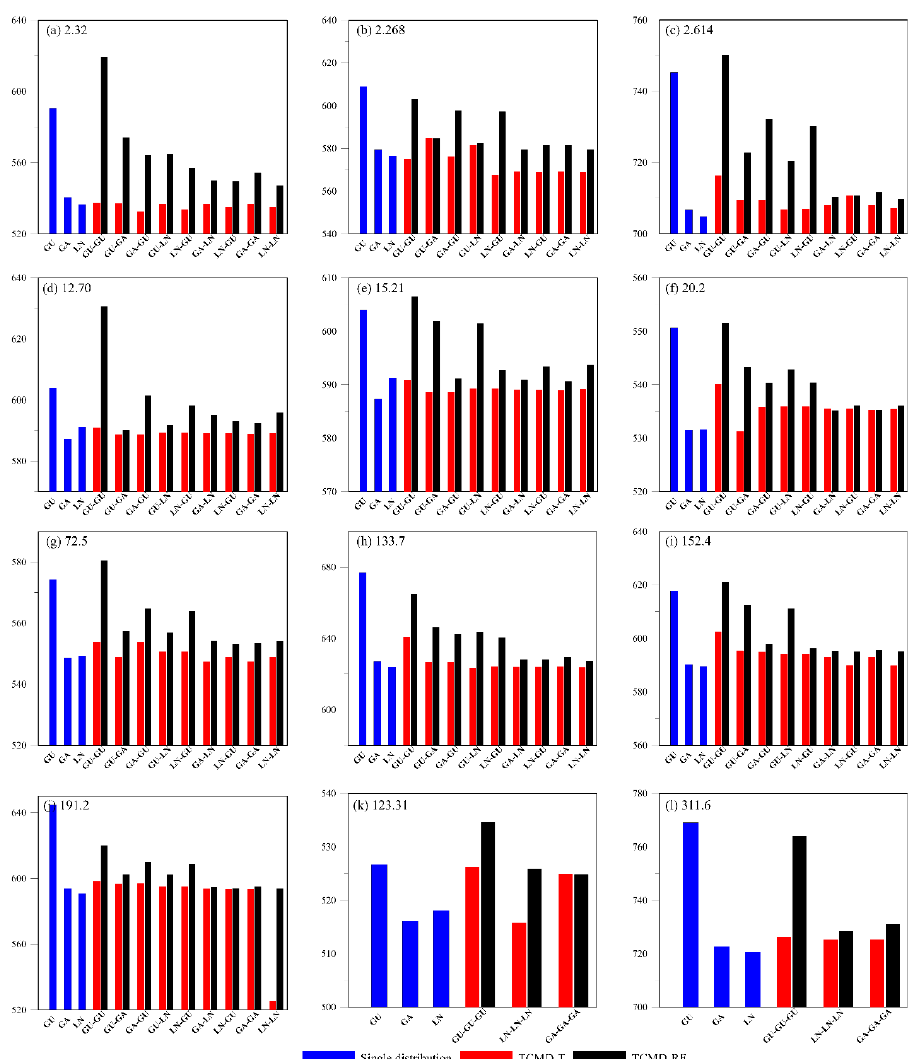
Figure 8. The AIC values of the single distribution model and mixture distributions, namely TCMD-T and TCMD-RF, with various component distributions.